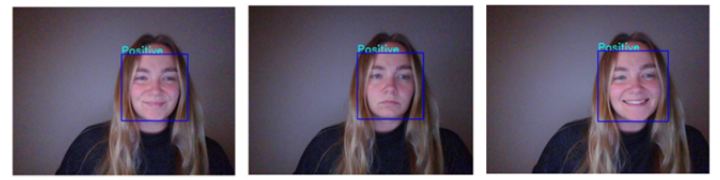
Figure 26. Correctly Classified Real-Time 3 × Positive.